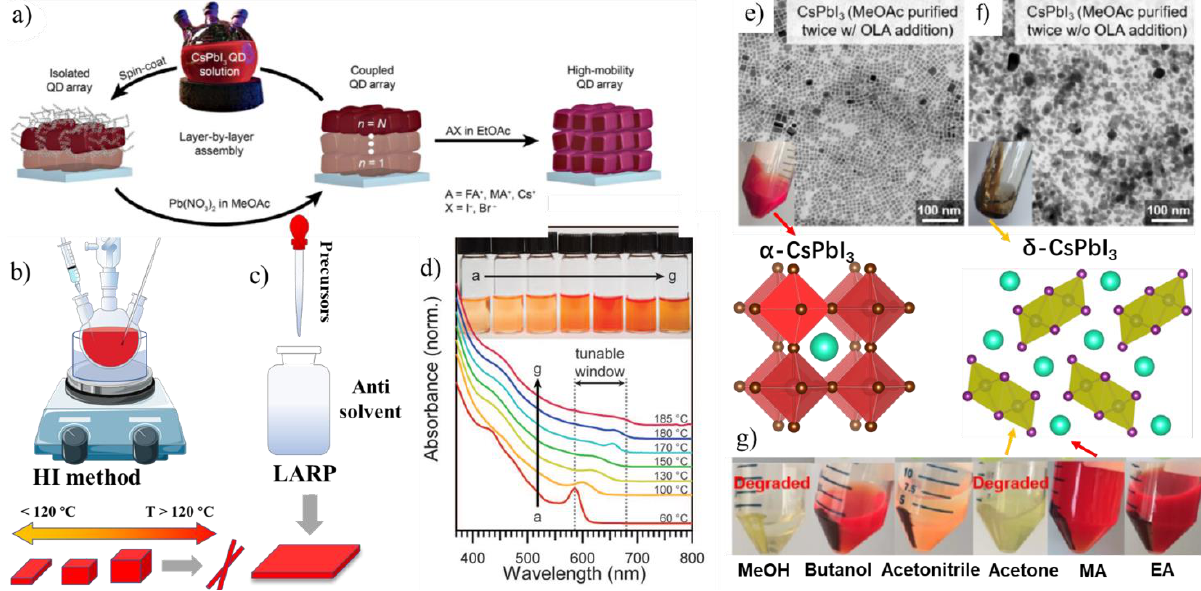
Figure 7. ( a ) Schematic representation of CsPbI 3 NCs film deposition process with MeOAc and AX salt post-treatment. The figure adapted with permission from [38]; Copyright 2017 AAAS. ( b , c ) sche- matic of the hot injection and LARP methods; ( d ) UV-visible absorption spectra of quantum con- fined CsPbI 3 NCs synthesized at different temperatures. The figure adapted with permission from [71]; Copyright 2016 AAAS. ( e – g ) are photographs and TEM images to display the influence of washing procedures while sedimenting the CsPbI 3 NCs with the number of washing times and type of solvents used. The figure adapted with permission from [137], Copyright 2018 American Chem- ical Society.